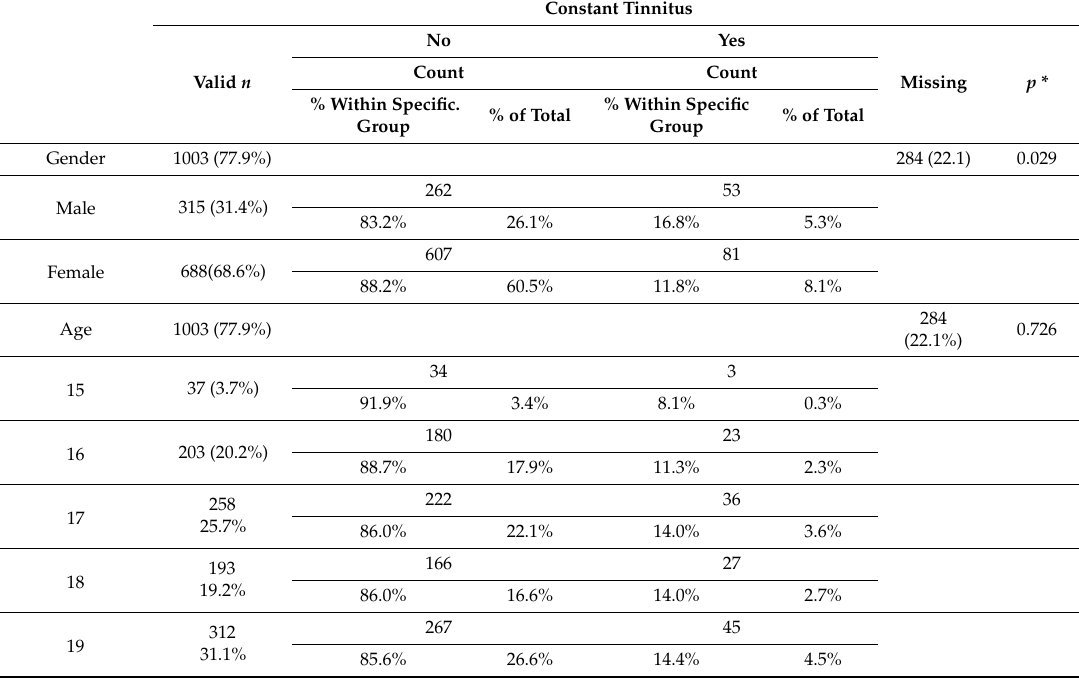
Table 1. Sociodemographic characteristics of the investigated